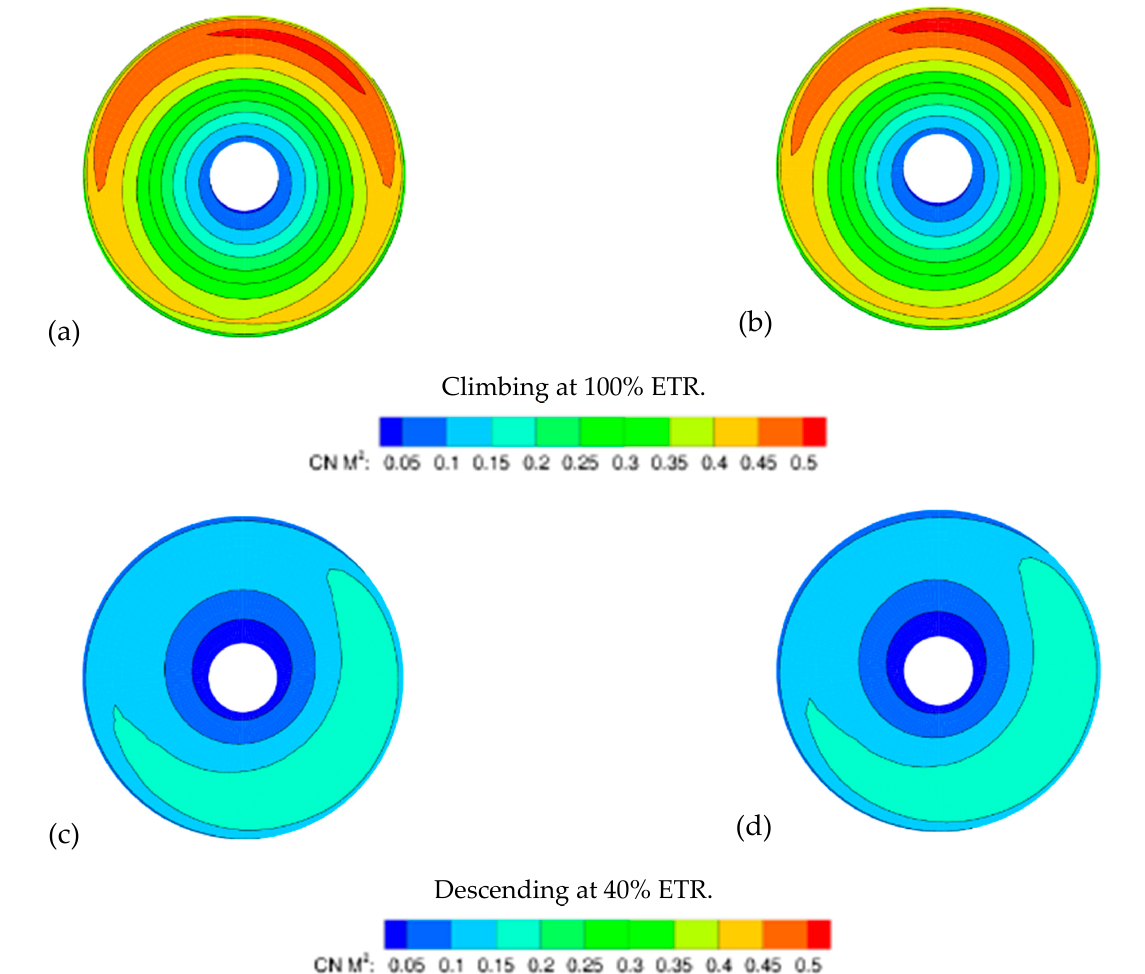
Figure 14. Configuration A—CN M 2 distribution on propellers’ disks. Starboard side ( a , c ); portside ( b , d ), in the two cases of Climbing ( a , b ) and Descent ( c , d ) flight.